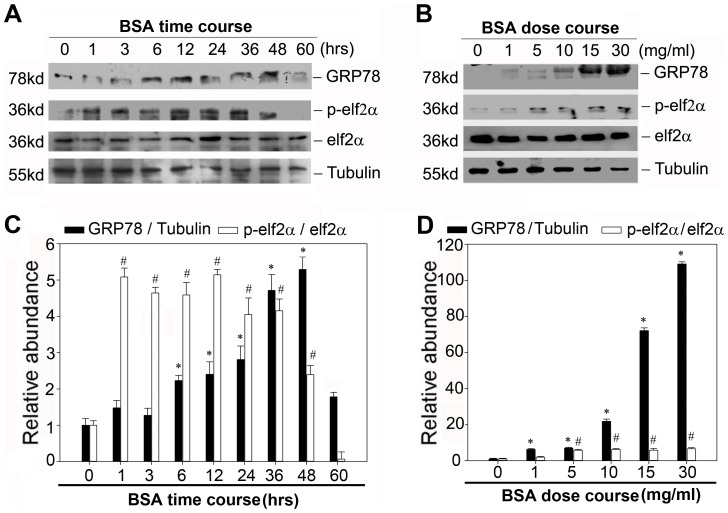
Bovine serum albumin induced endoplasmic reticulum stress in NRK-52E cells.A. Western blot analysis shows the expression of GRP78 and the phosphorylation of eIF2a in NRK-52E cells after treatment without or with 5 mg/ml BSA for various time periods in serum-free medium. The whole cell lysate was immunoblotted with GRP78, phosphorylated- eIF2α and eIF2α antibody, respectively. The same blot was reprobed with α-tubulin to confirm equal loading of each lane. B. Western blot analysis shows the expression of GRP78 and the phosphorylation of eIF2a in NRK-52E cells without or with different amounts of BSA for 12 h in serum-free medium. C and D: Graphical presentation shows the relative abundances of GRP78 after normalization with α-tubulin and the phosphorylation of eIF2α after normalization with eIF2α. Data are presented as mean±SEM of three independent experiments. *P<0.05 vs. normal control (the relative abundance of GRP78 protein level); # P<0.05 vs. normal control (the phosphorylation of eIF2α).